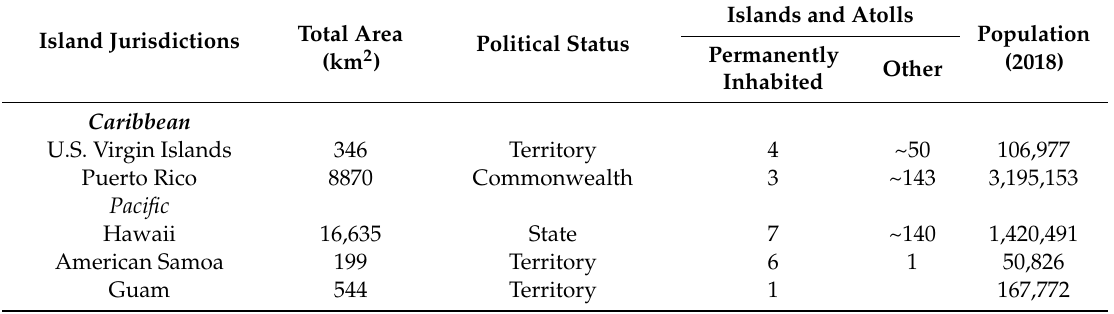
Table 2. Characteristics of the nine island jurisdictions in the study area (listed from east to